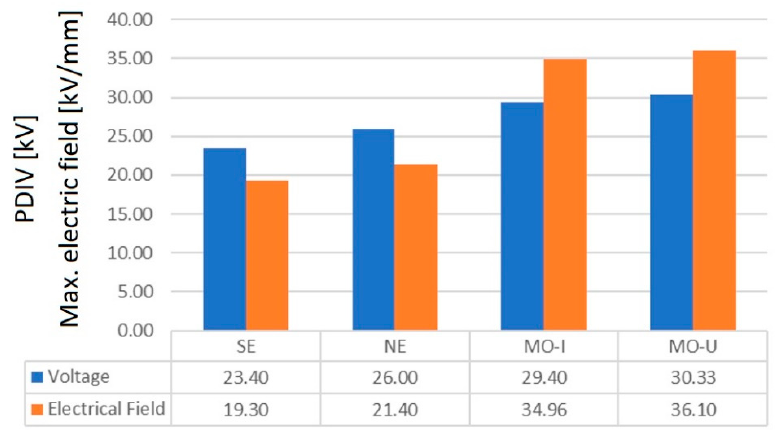
Figure 8. PDIV and maximum electric field in the oil wedge for the tested electrode